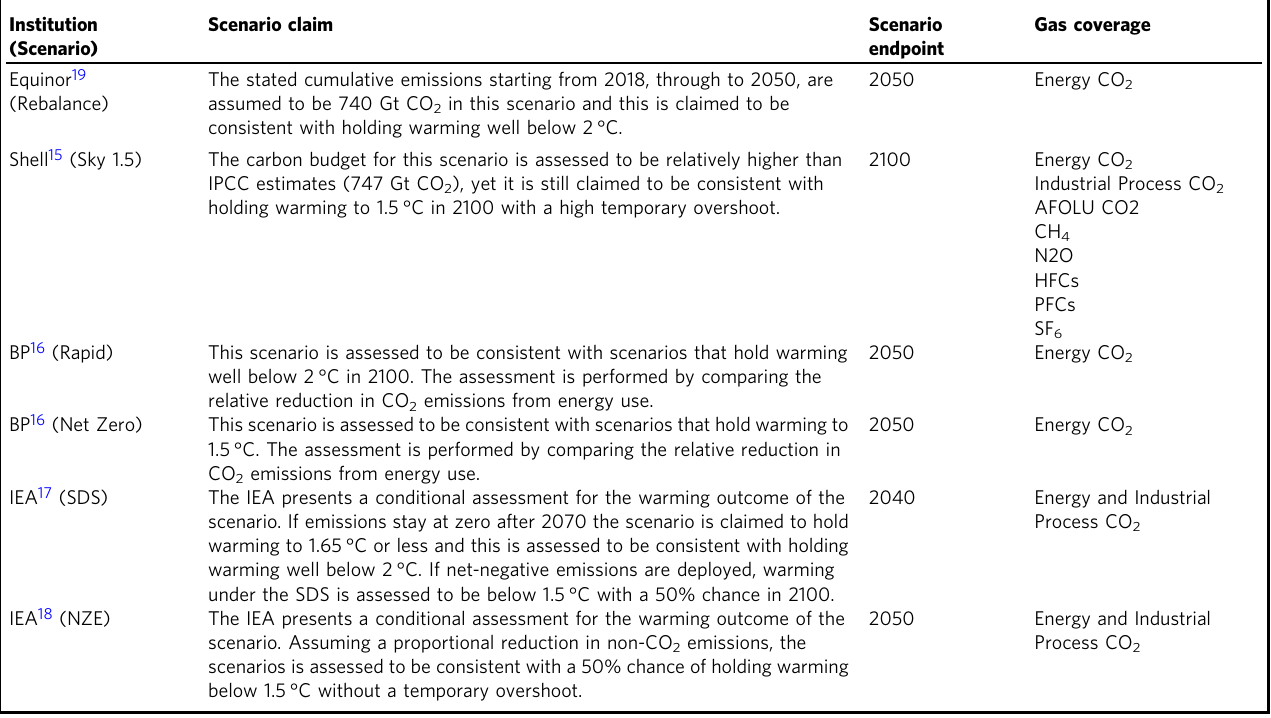
Table 1 Institutional scenario characteristics — claims, time horizon and gas